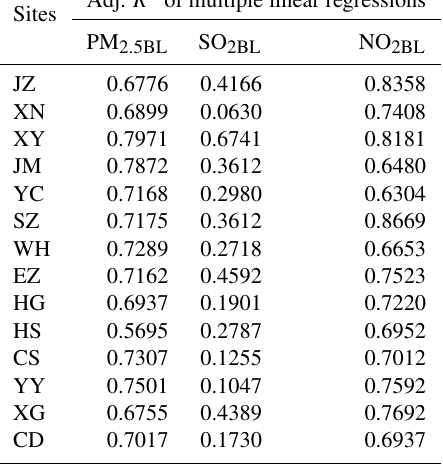
Table 1. Adjusted determination coefficients (Adj. R 2 ) between the baseline components decomposed by the KZ filter and fitted with multiple linear regressions, respectively, for PM 2 . 5BL , SO 2BL and NO 2BL in 14 sites over the THB. All Adj. R 2 passing the confidence level of 99%.